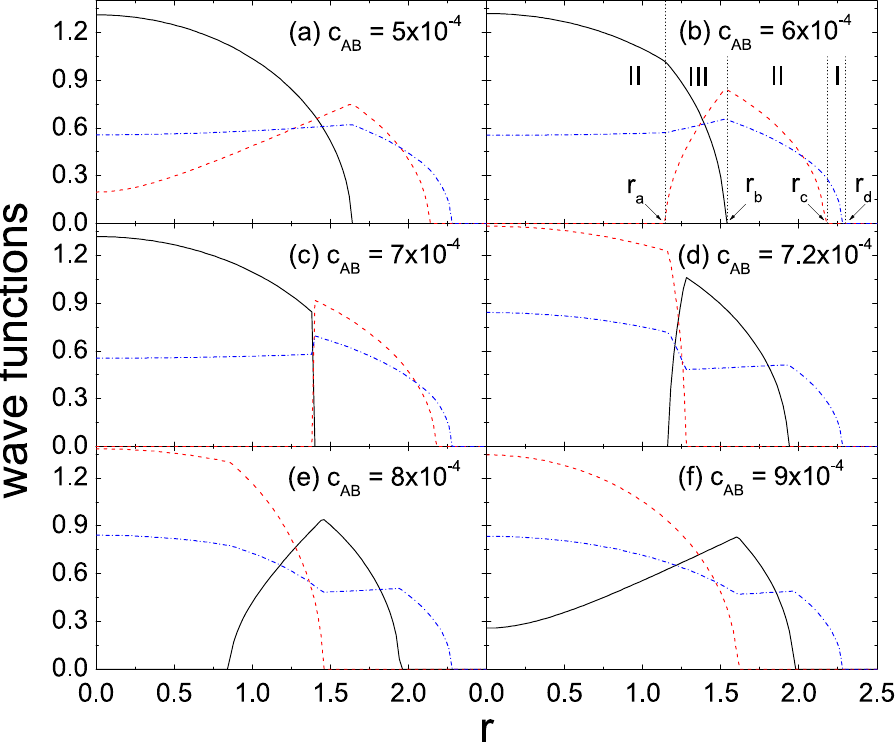
Figure 1. Wave functions u 1 / r (in solid line), u 2 / r (in dash line), and u 3 / r (in dash-dot line) against r . ħ ω and λ ω ≡ m /( )  are used as units for energy and length. c AB is given at six values marked in the panels. Other o parameters are fixed and are chosen quite arbitrary but having p BC and p CA both being negative. They are N A = 30000, N B = 11000, N C = 29000, c A = 4 × 10 − 4 (in ħ ωλ 3 , the same for other strengths), c B = 1.4 × 10 − 3 , c C = 1.2 × 10 − 3 , c BC = 3.8 × 10 − 4 , c CA = 4.2 × 10 − 4 , γ A = γ B = γ C = 1. In 1b, the Forms of the solutions are marked in the associated domains separated by the vertical dotted